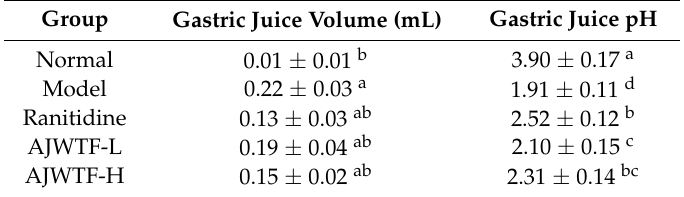
Table 2. Volume and pH of gastric fluid in mice from each group ( n =